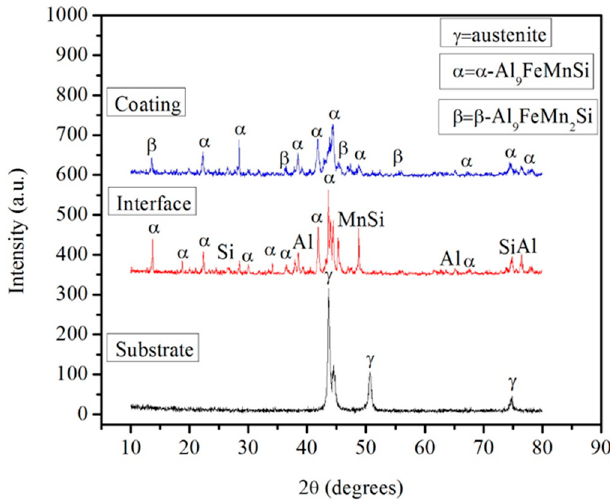
Figure 4. X-ray diffraction patterns of the AISI 304L stainless steel substrate, the interface and the coating, for a sample processed at a temperature of 850 °C and a pressure of 20 MPa for 7200 s.